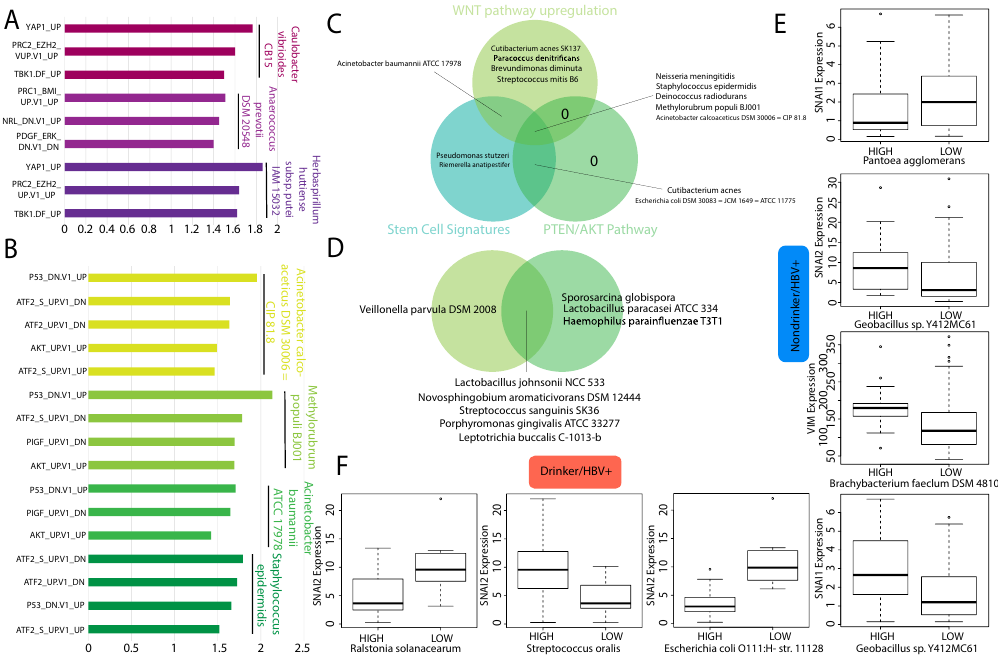
Figure 5. Correlation of microbial abundance to cancer-associated pathway expression. Downregulation of microbes in the ( A ) HBV − / drinker cohort and ( B ) the HBV +/ nondrinker cohort are correlated to increased expression of cancer signatures that correlates with advanced clinical stages. ( C ) Clinically relevant microbial downregulation in the HBV +/ nondrinker cohort is correlated to stem cell-associated signatures, which is not observed in ( D ) HBV +/ drinker microbes. Co-regulation of stem cell-associated genes was observed in ( E ) the HBV +/ nondrinker cohort and ( F ) the HBV +/ drinker